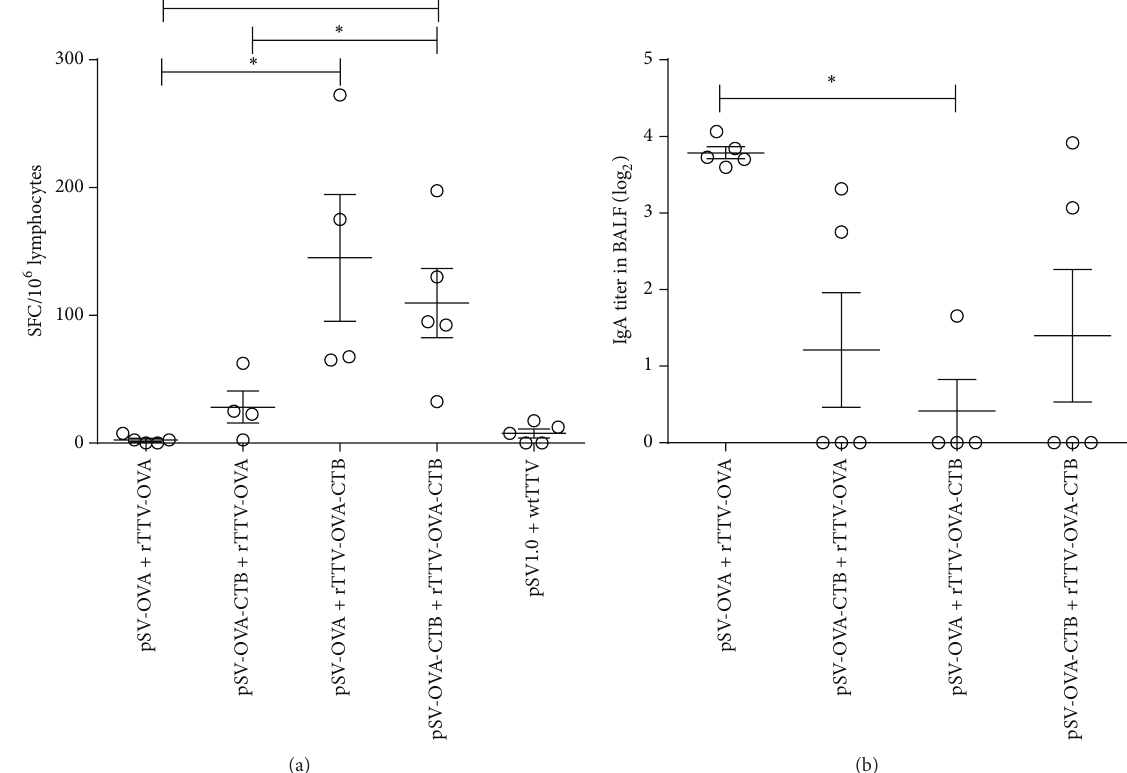
Figure 2: Specific antibody and T-cell immune responses elicited in respiratory tract. (a) Ovalbumin specific T-cell response in cervical and axillary lymph nodes. Significant differences were observed between rTTV-OVA-CTB boosting groups and rTTV-OVA boosting groups. (b) Specific IgA titer in bronchial alveolar lavage. The average OVA specific IgA titer induced by pSV-OVA priming/rTTV-OVA boosting was significantly higher than pSV-OVA priming/rTTV-OVA-CTB boosting group. ∗ 𝑃 < 0.05 , ∗∗ 𝑃 < 0.01 .